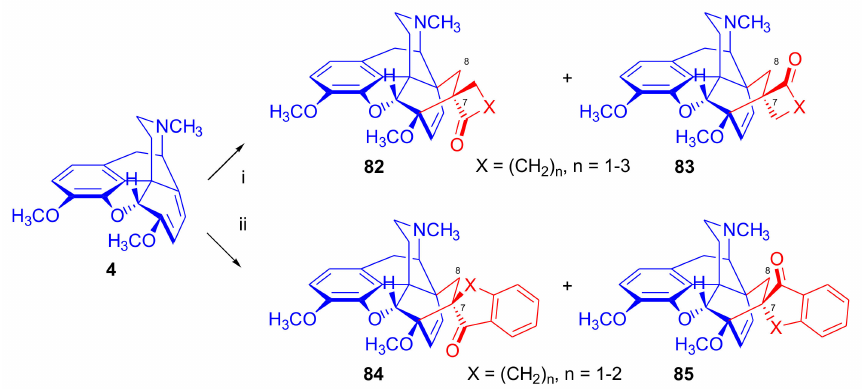
Figure 26. Spiro-7,7-disubstituted-6,14-ethenomorphinans. Reagents and conditions : (i) 1.4 equiv. Mannich salt, 1.5 equiv. sodium carbonate, toluene, reflux, 2–14 days; (ii): 2-methyleneindan-1-one.